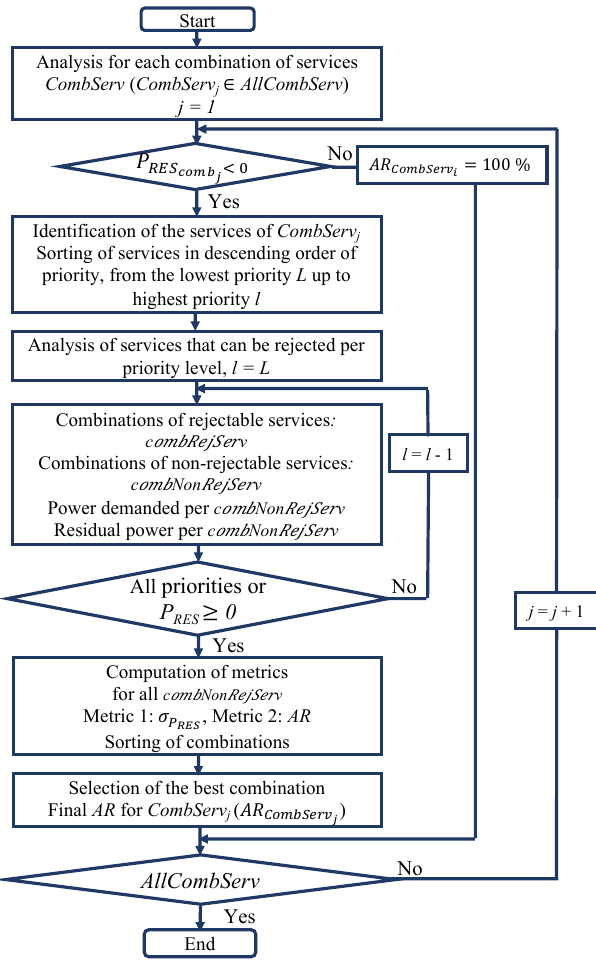
Figure 3. Flow chart for AR computation of O PT T S when there exist service rejection. Table 3. Parameters of services or power